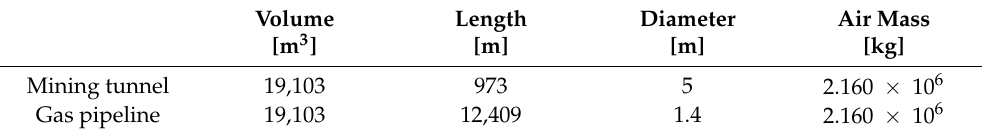
Table 2. Main characteristics of the two compressed air storage reservoirs.